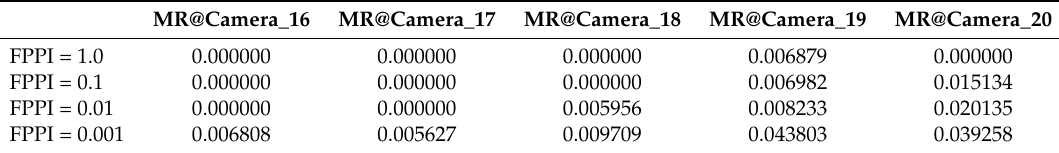
Table 5. Accuracy table @ Cameras_16–20, informed-filters.